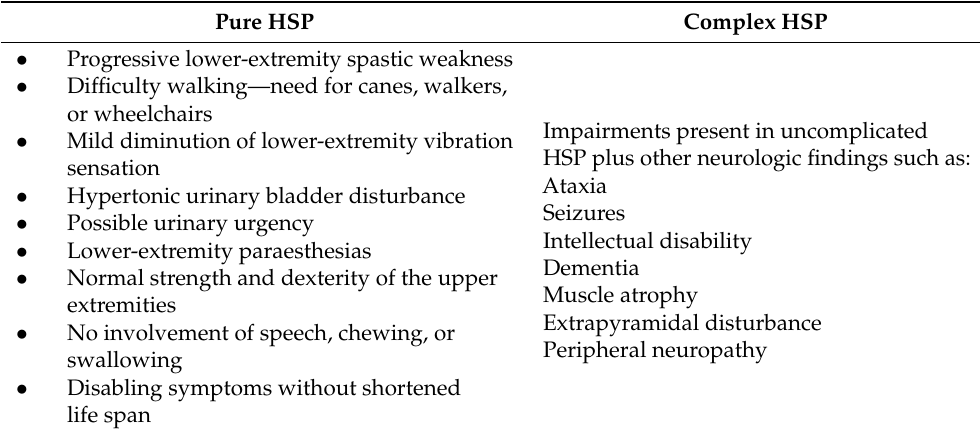
Table 1. The clinical manifestations of pure and complex HSP and a list of the prevalent clinical manifestations observed in HSP.